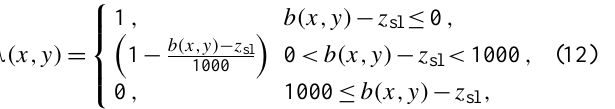
Fig. 2. Superposition of SIA and SSA velocities. Upper panel: a schematic diagram of an ice profile showing the different flow regimes in PISM-PIK. Repeats Fig. 1 from Winkelmann et al. (2011). Lower panel: an example cut through the sheet-stream-shelf transition of the Lambert Glacier and Amery Ice Shelf in the simulation. The location is shown by the green line in Fig. 8. The onset of an ice stream is defined diagnostically to be where the basal sliding velocity v b (red curve) exceeds the SIA velocity v SIA (blue curve). The model output velocity v = v b + v SIA is shown in black.